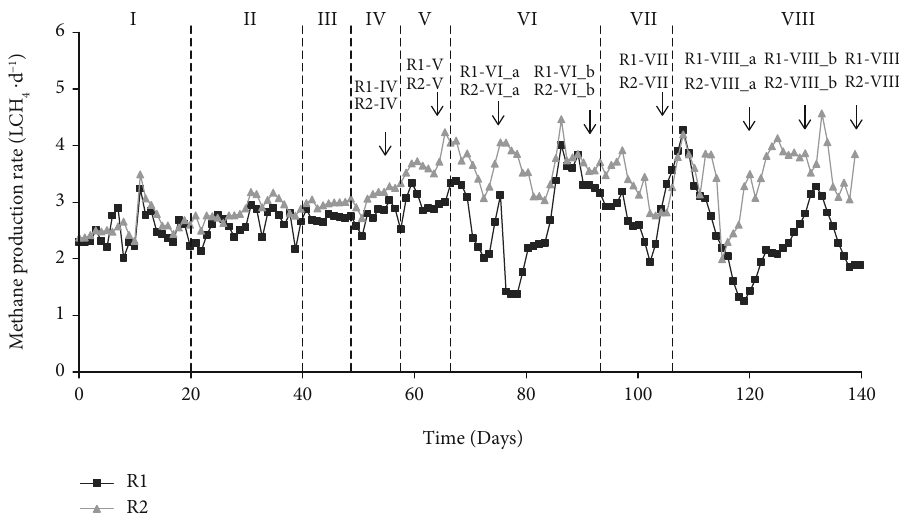
Figure 1: Methane rate produced by R1 and R2 reactors during the experiment; arrows indicate DNA extraction sampling points: labels include the name of the reactor sampled (R1 or R2), the experimental period in roman letters, and when needed, a letter to distinguish samples from the same reactor and period (a, b, or